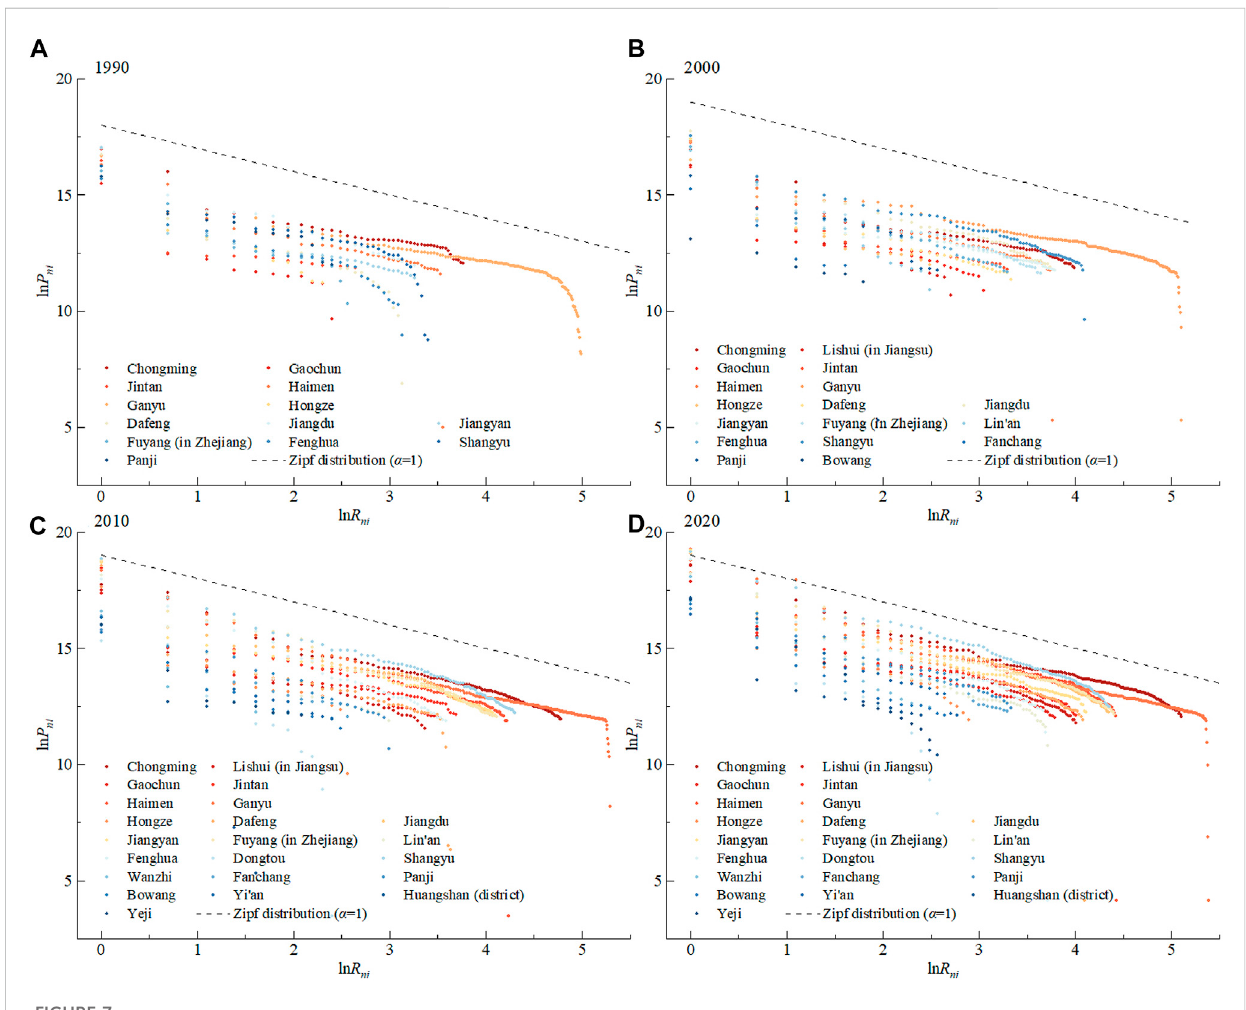
FIGURE 7 Intra city-size distribution of YRDR (districts).